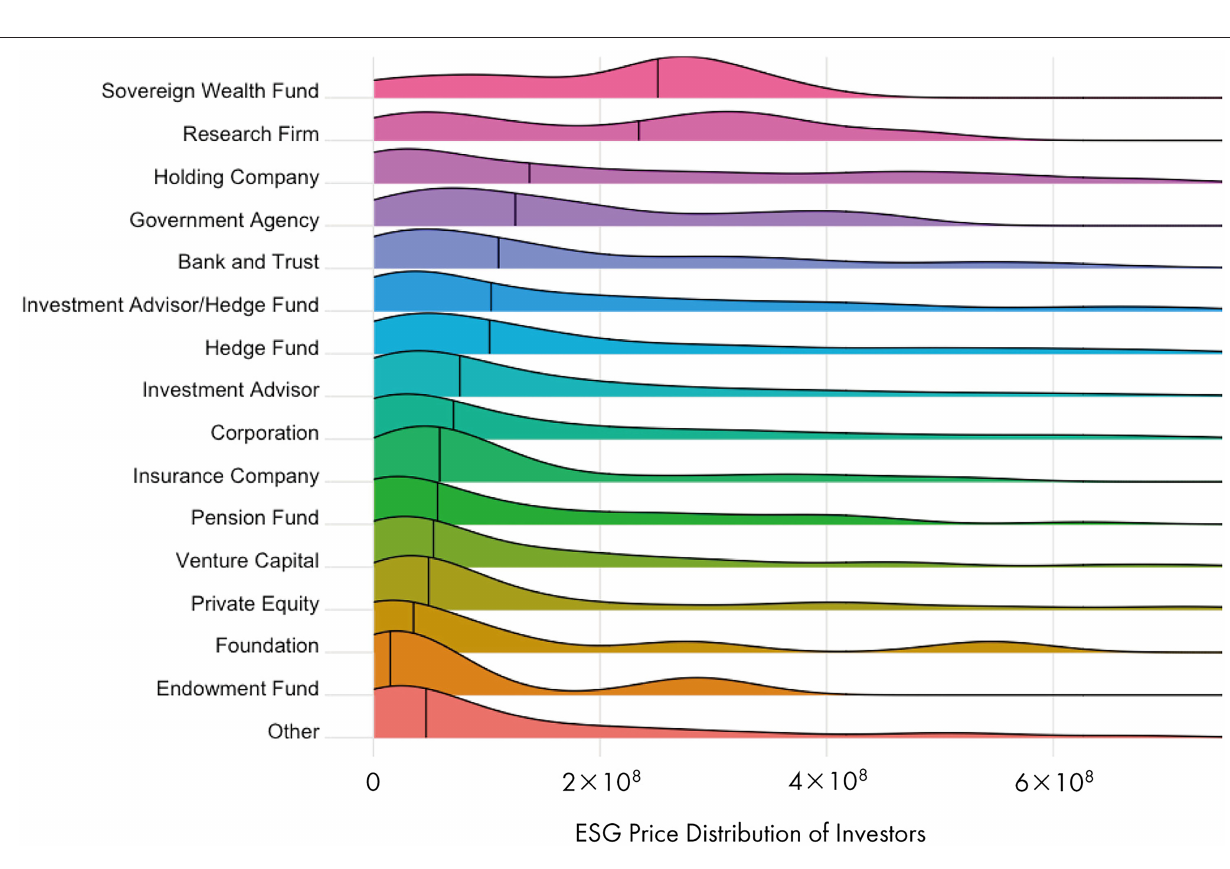
Frontiers in Sustainability |